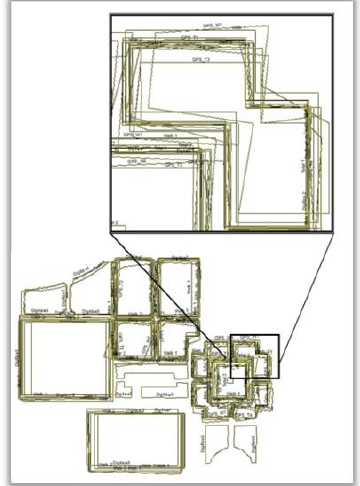
Figure 6. Overlay of the ten datasets collected from the